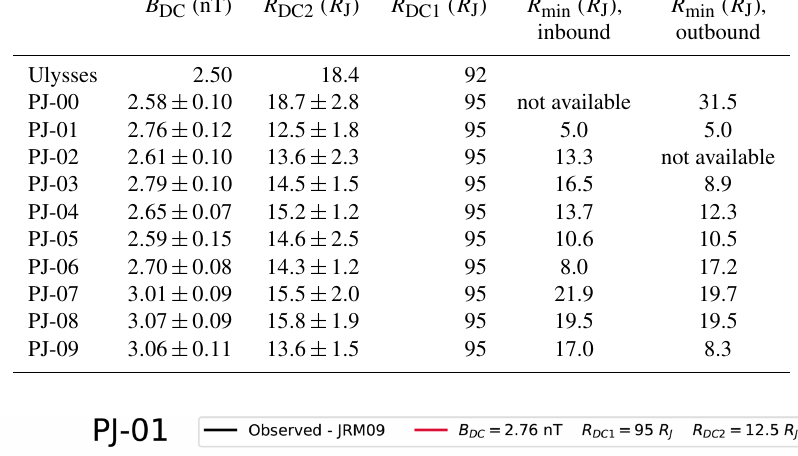
Table 1. Magnetodisc parameters derived for the Ulysses inbound pass and the first 10 Juno orbits, together with the estimated errors and the minimum inbound and outbound radial distances available in the Juno passes.